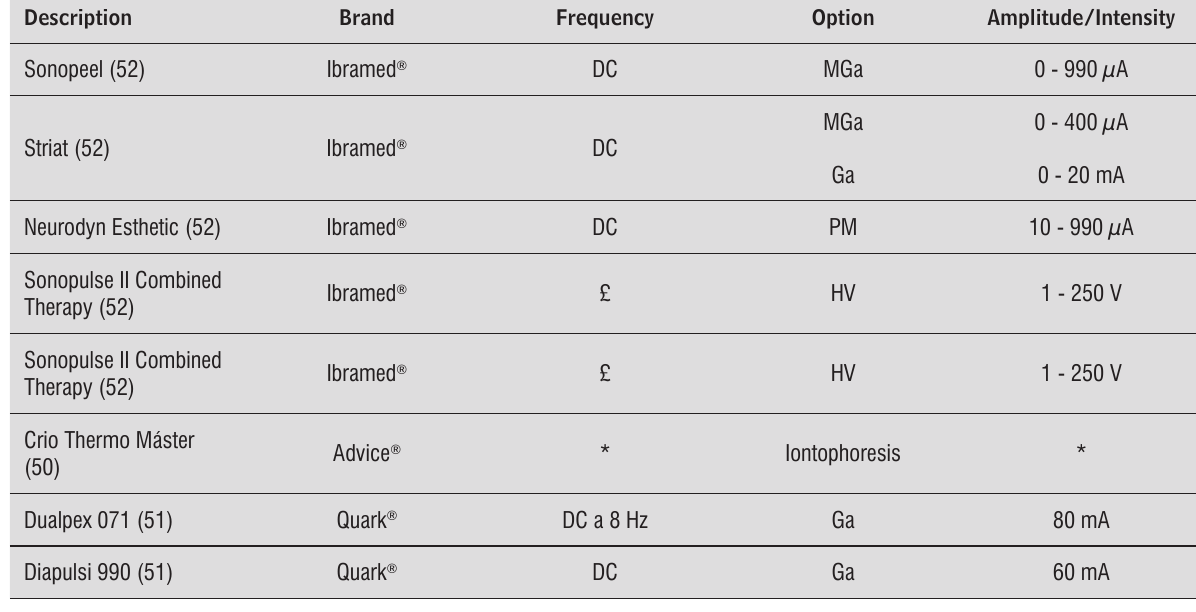
Table 1 - National commercial devices with the option for applying iontophoresis/electroporation Description Brand Frequency